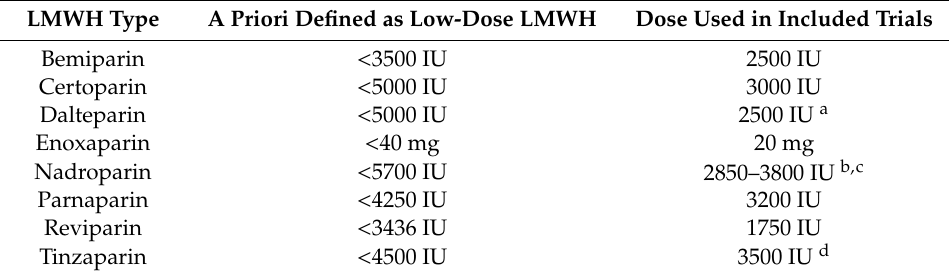
Table 1. LMWH dose